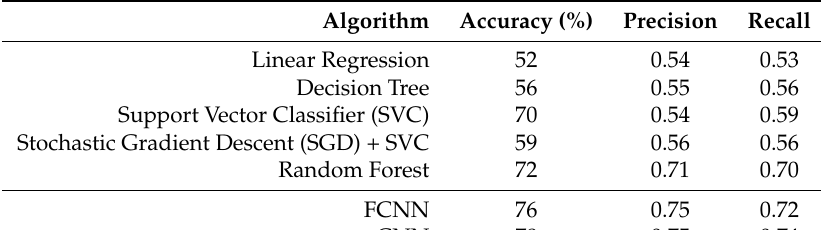
Table 3. Three-class classification results.